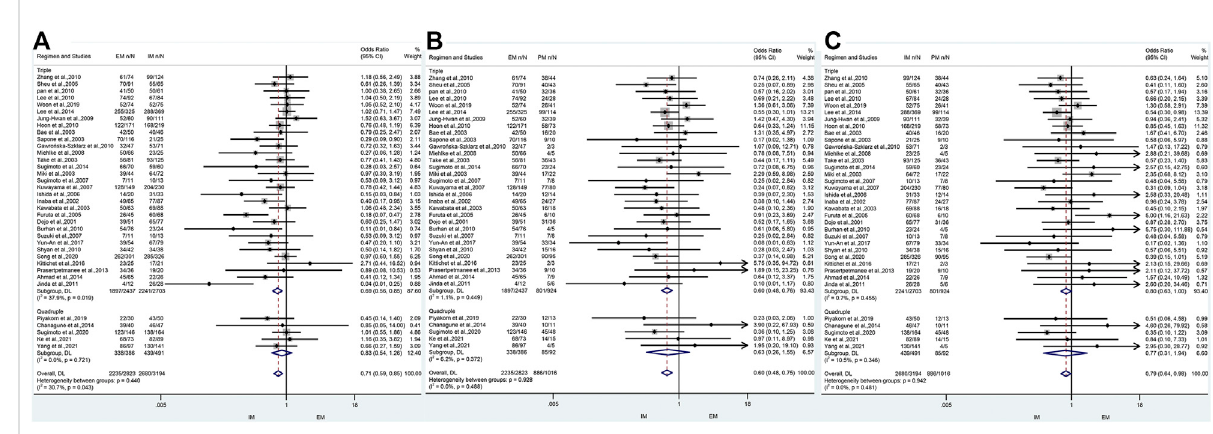
FIGURE 7 (A) Forest plot of EM vs. IM in relation to the H. pylori cure rate in the CYP2C19 genotype in different treatment regimens ( p = 0.043). (B) Forest plotofEMvs.PMinrelationtothe H.pylori curerateintheCYP2C19genotypeindifferenttreatmentregimens( p =0.488). (C) ForestplotofIMvs.PM in relation to the H. pylori cure rate in the CYP2C19 genotype in different treatment regimens ( p = 0.481). p = 0.05, signi fi cant heterogeneity or statistically signi fi cant, when appropriate. p < 0.05, random-effects model; p > 0.05, random-effects model. Symbol: , single studies included in the meta-analysis; , sample size of single studies; , con fi dence interval (CI); , overall pool estimated; , tendency; , overall pool OR.